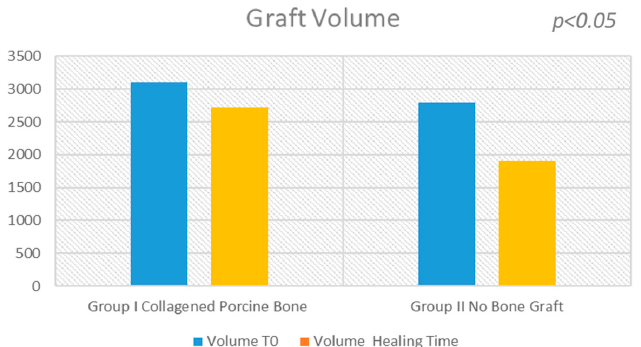
Figure 2. The evaluation shows a high statistical difference between the Group I (collagened porcine bone) and the Group II (no bone graft). At six months, the sinus bone gain in the non-graft group was significantly lower than in the graft group (504.6 mm 3 ; 95% CI: 406.5 to 602.6; p < 0.05).